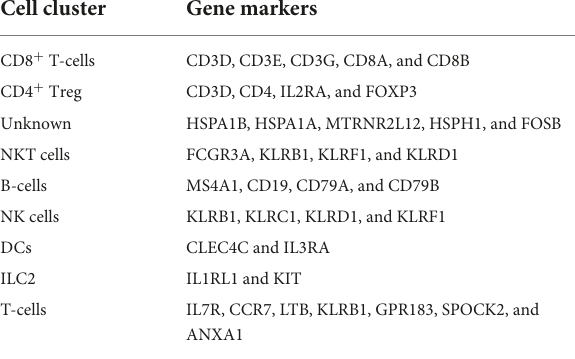
TABLE 1 Markers used for annotating the cell